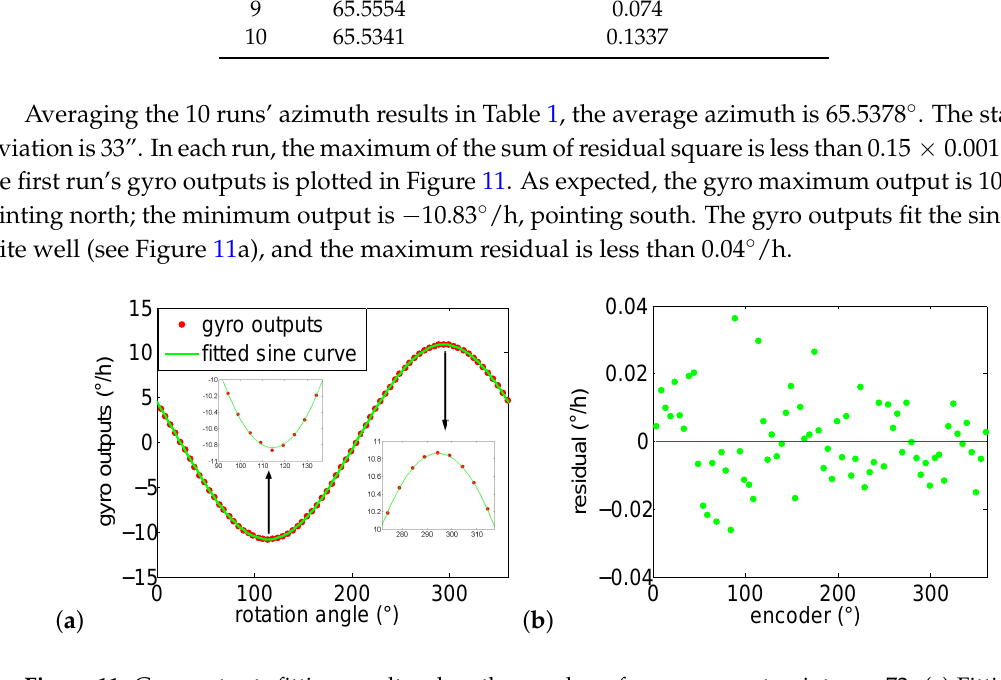
Figure 11. Gyro outputs fitting results when the number of measurement points n = 72. ( a ) Fitting curve when n = 72; ( b ) Residual of the corresponding fitting curve.